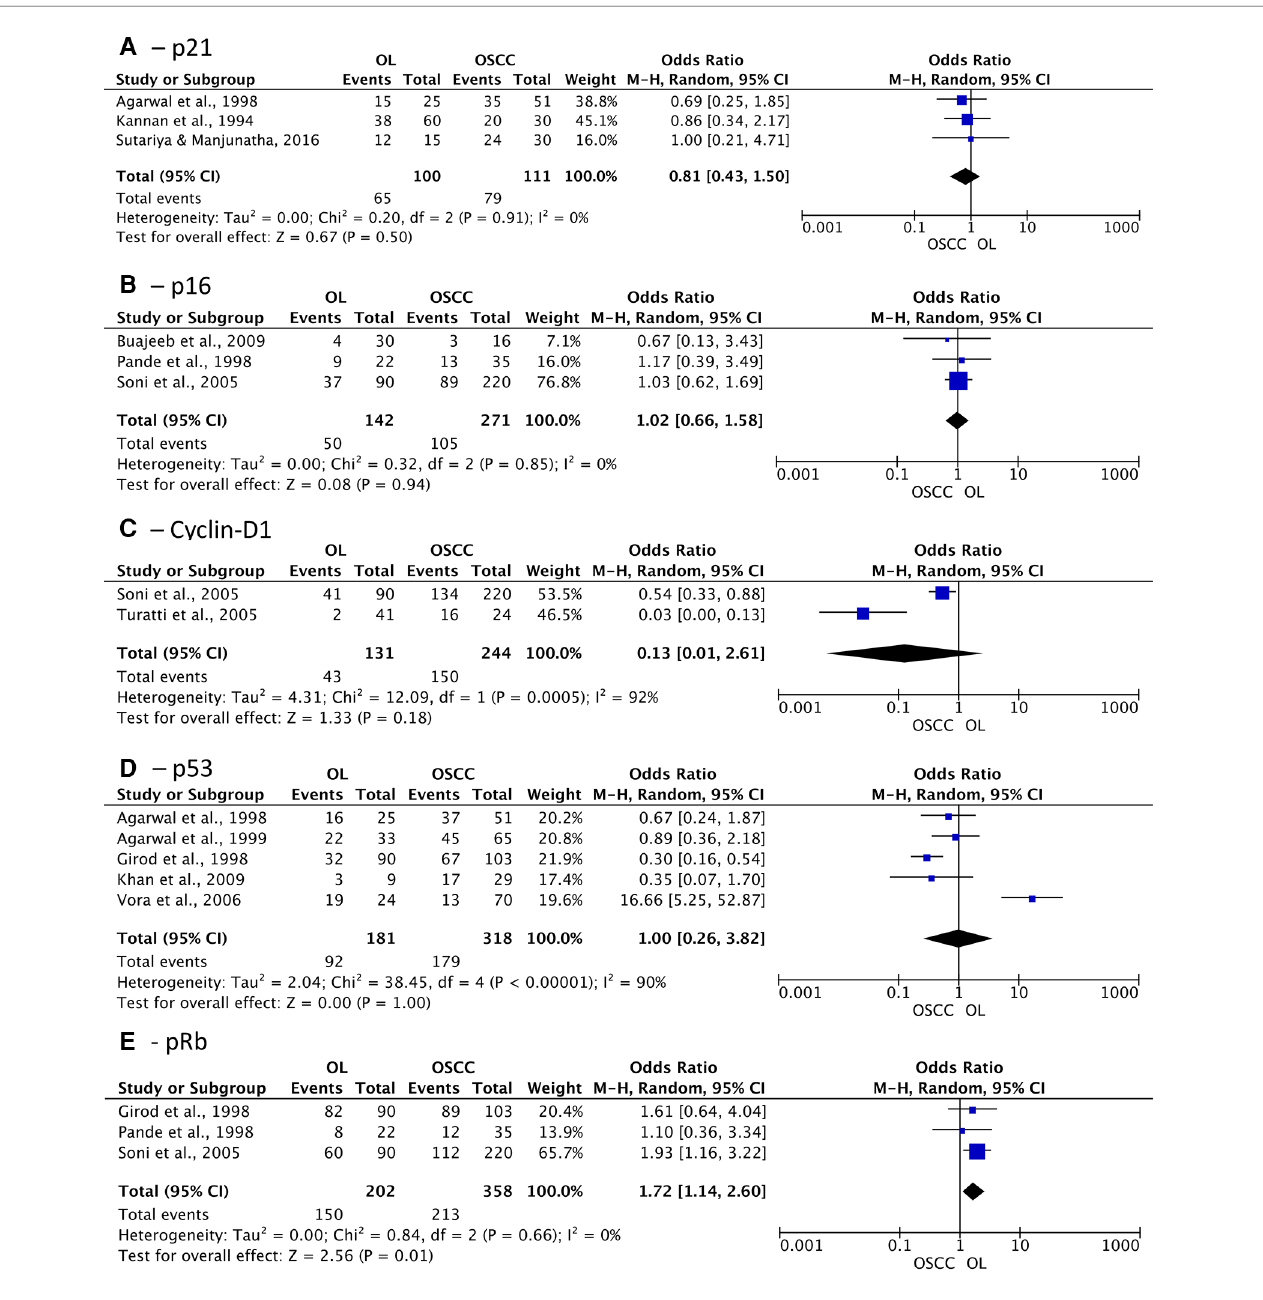
FIGURE 4 Association of expression of tumor suppressor proteins in oral leukoplakia (OL) compared to oral squamous cell carcinoma (OSCC). ( A ) p21; ( B ) p16; ( C ) Cyclin-D1; ( D ) p53; ( E )